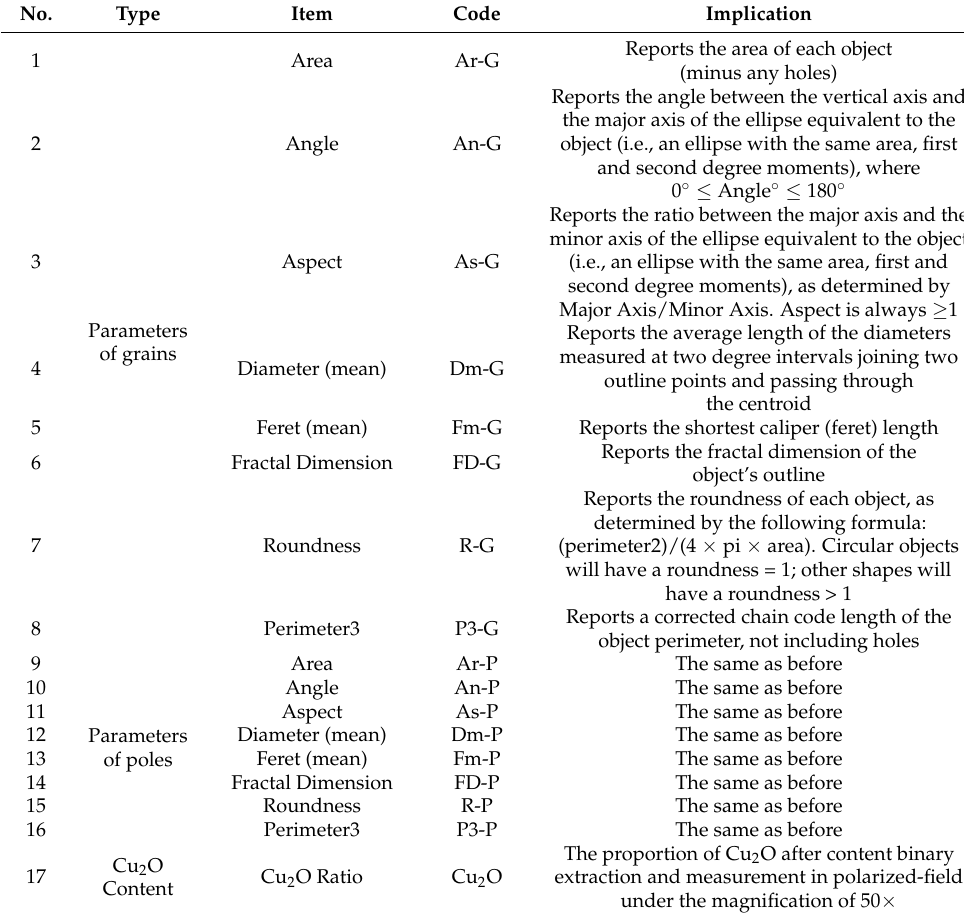
Table 1. Metallurgical characteristics parameters of melted beads on stranded copper